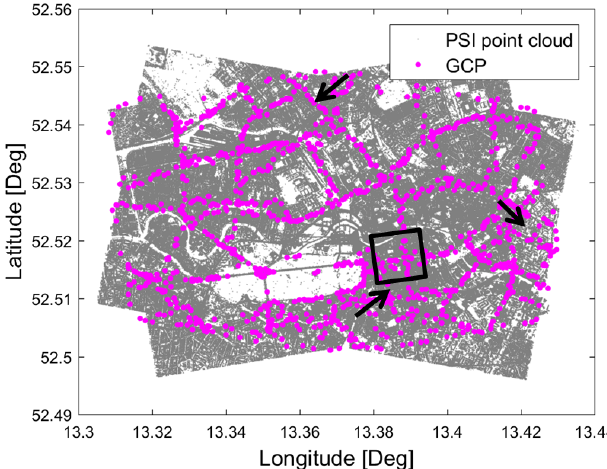
Figure 11. Distribution of the GCPs within the PSI point clouds of both beams. The test sites used for vertical and horizontal accuracy analysis are marked with black rectangle and black arrows,